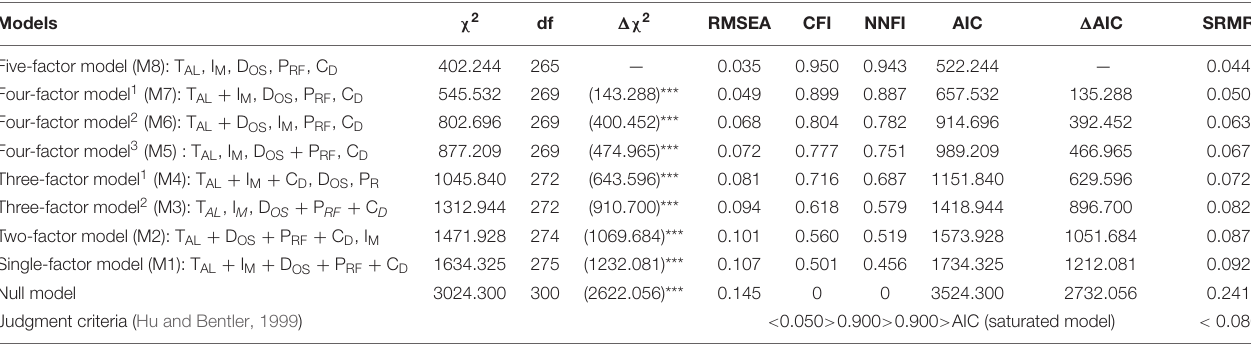
TABLE 3 | Confirmatory factor analysis.